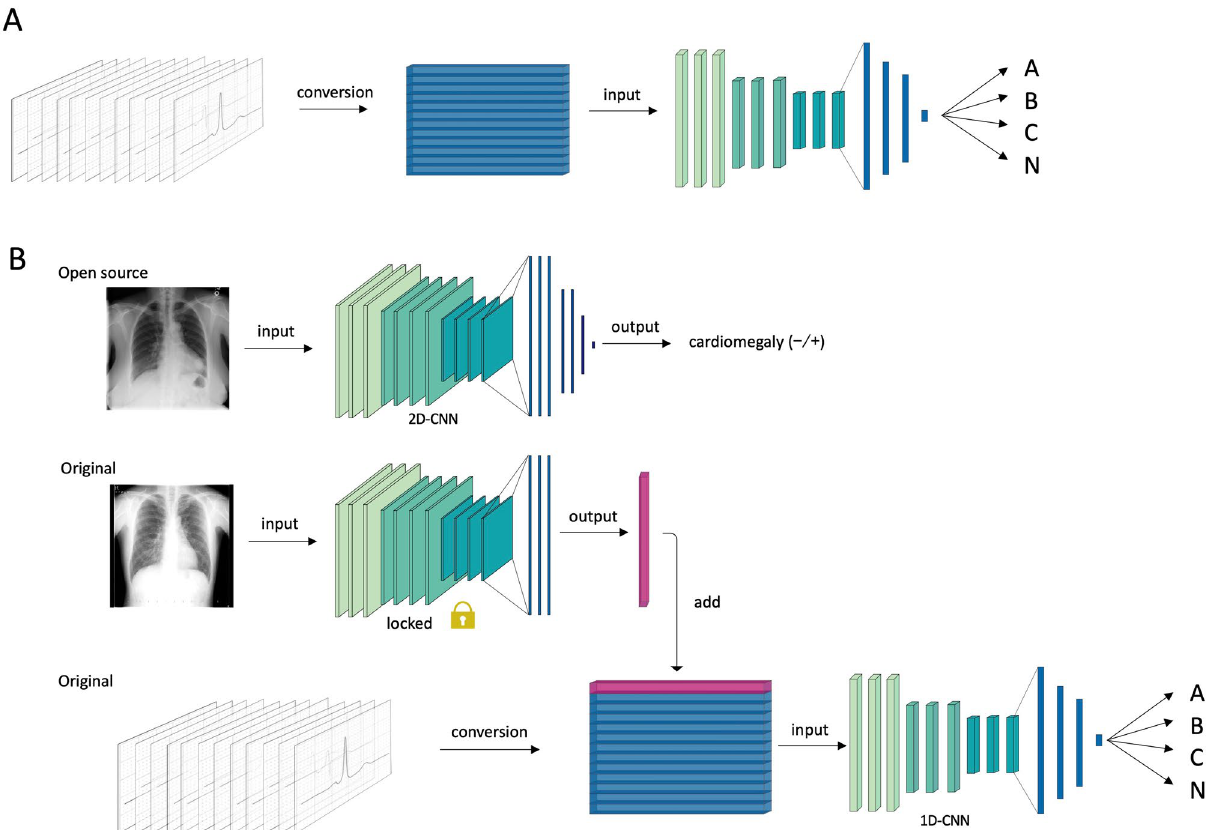
Figure 3. Overview of the deep learning architecture. ( A ) For the primary output, 206 ECGs were loaded into the convolutional neural network model and classified into four classifications (Group A, Group B, Group C, and Group N [normal class]). ( B ) For the secondary output, chest X-ray images from 1519 patients were used for pretraining, and the original chest X-ray images were compressed into a one-dimensional vector using the pretrained midlayer weights. The combined ECG and chest X-ray data were finally trained to classify the outputs. 2D-CNN indicates a two-dimensional convolutional neural network, and 1D-CNN indicates a one- dimensional convolutional neural